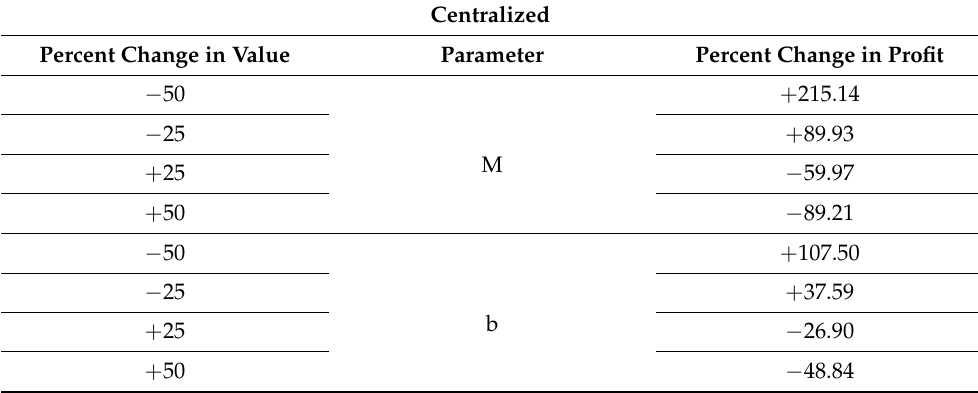
Table 6. Centralized key parameter